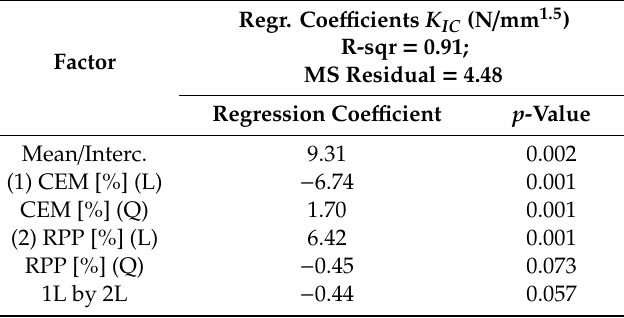
Table 14. Experimental coe ffi cients for fracture toughness K